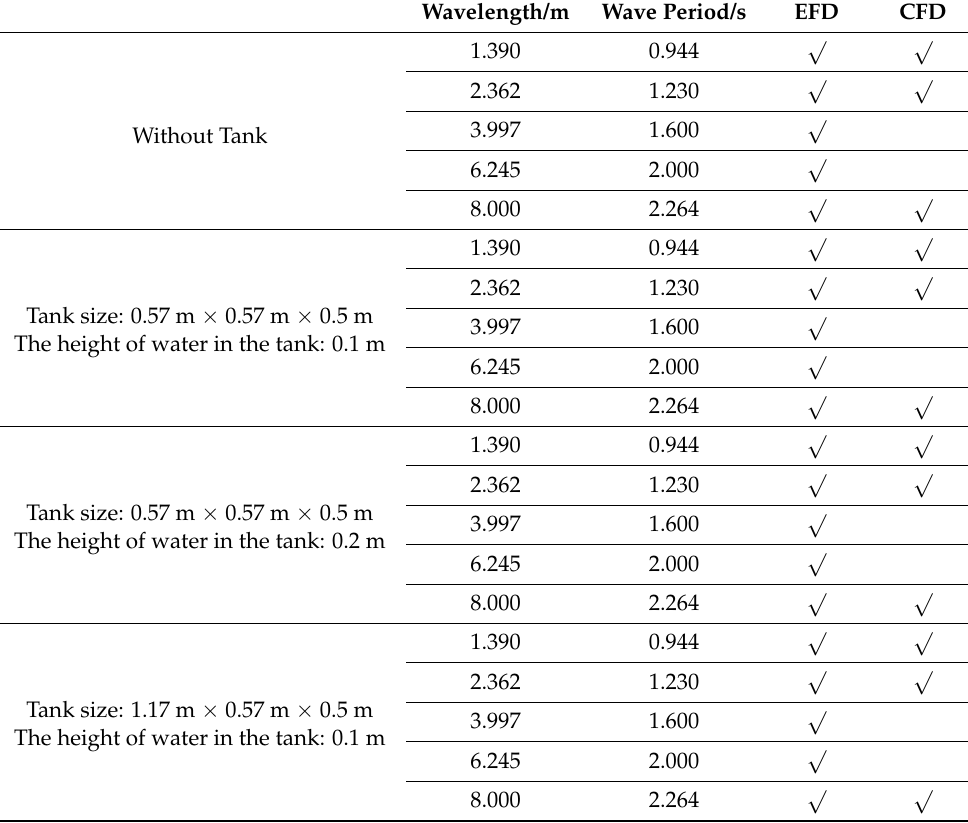
Wavelength/m Wave Period/s EFD CFD 1.390